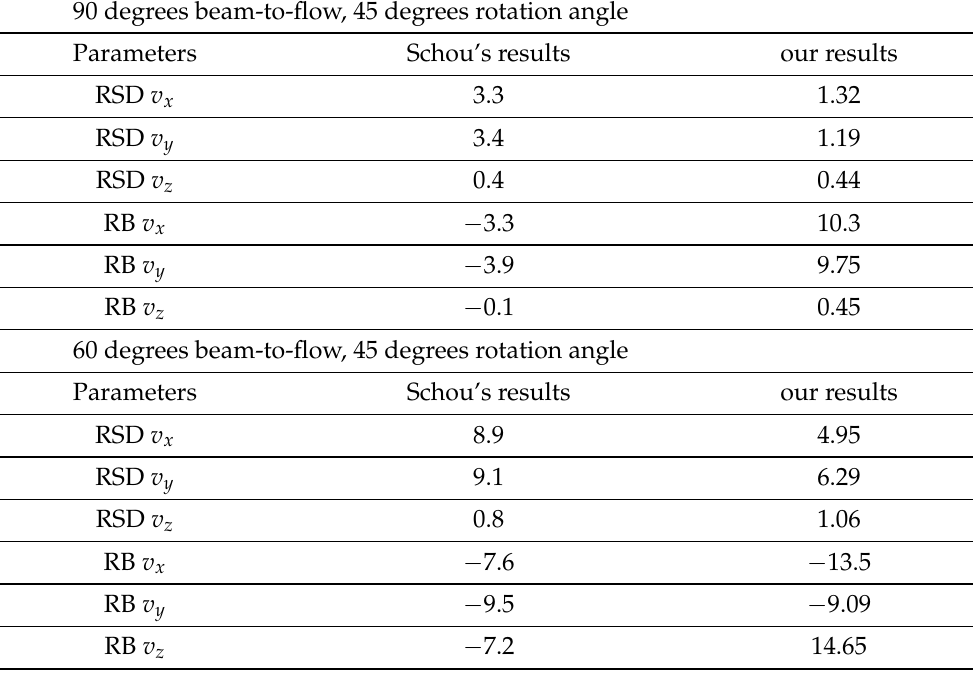
Table 2. Comparison of Schou’s method [24] and our